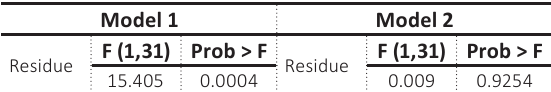
Table 9. Wooldridge test result